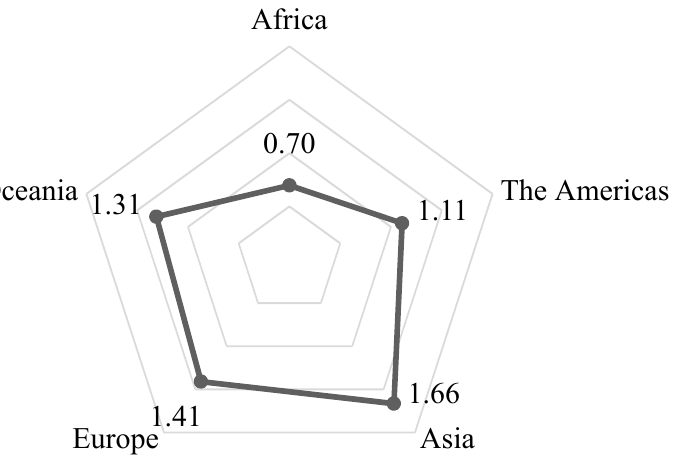
Figure 3. The green economy’s sustainability (IS) during the optimisation. Source: authors.